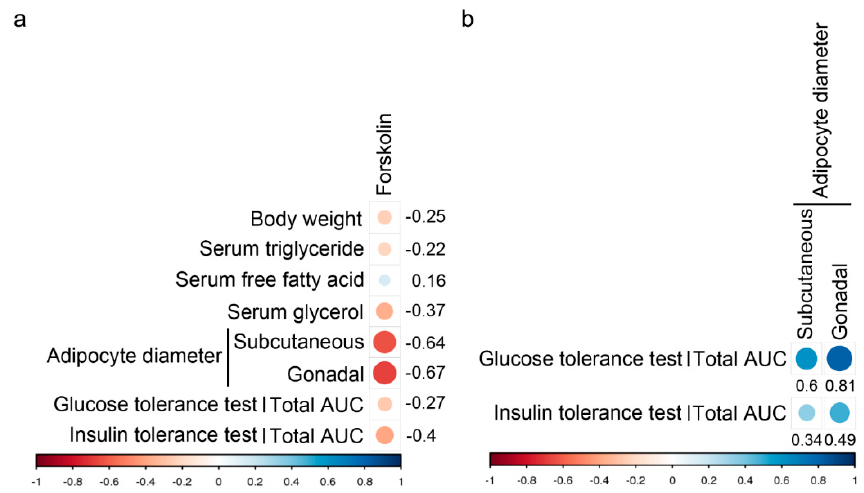
Figure 5. Pearson’s correlation analysis. ( a ) The correlation coefficient between the concentration of forskolin with body weight, serum lipid parameters (triglyceride, free fatty acid and glycerol), adipocyte size (subcutaneous and gonadal fat), or total AUC (glucose tolerance test and insulin tolerance test) in high-fat diet-induced mice. ( b ) The correlation coefficient between adipocyte size (subcutaneous and gonadal fat) and total AUC (glucose tolerance test and insulin tolerance test) in high-fat diet-induced mice. Positive correlations are displayed in blue and negative correlations are in red color. Circle sizes are proportional to the correlation coefficients.